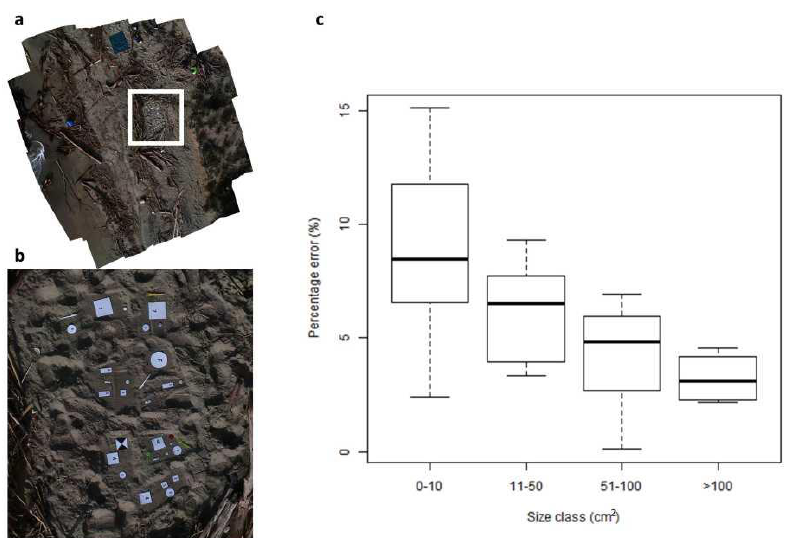
Figure 6. Error evaluation on items size (object surface) estimation. ( a ) Part of the whole study area; ( b ) zoomed-in view on the portion of beach used for validation, of about 18 m 2 ; ( c ) boxplot of percentage error (PE S ) per size class (in m 2 ). PE S was calculated using Microsoft Excel and boxplot were made